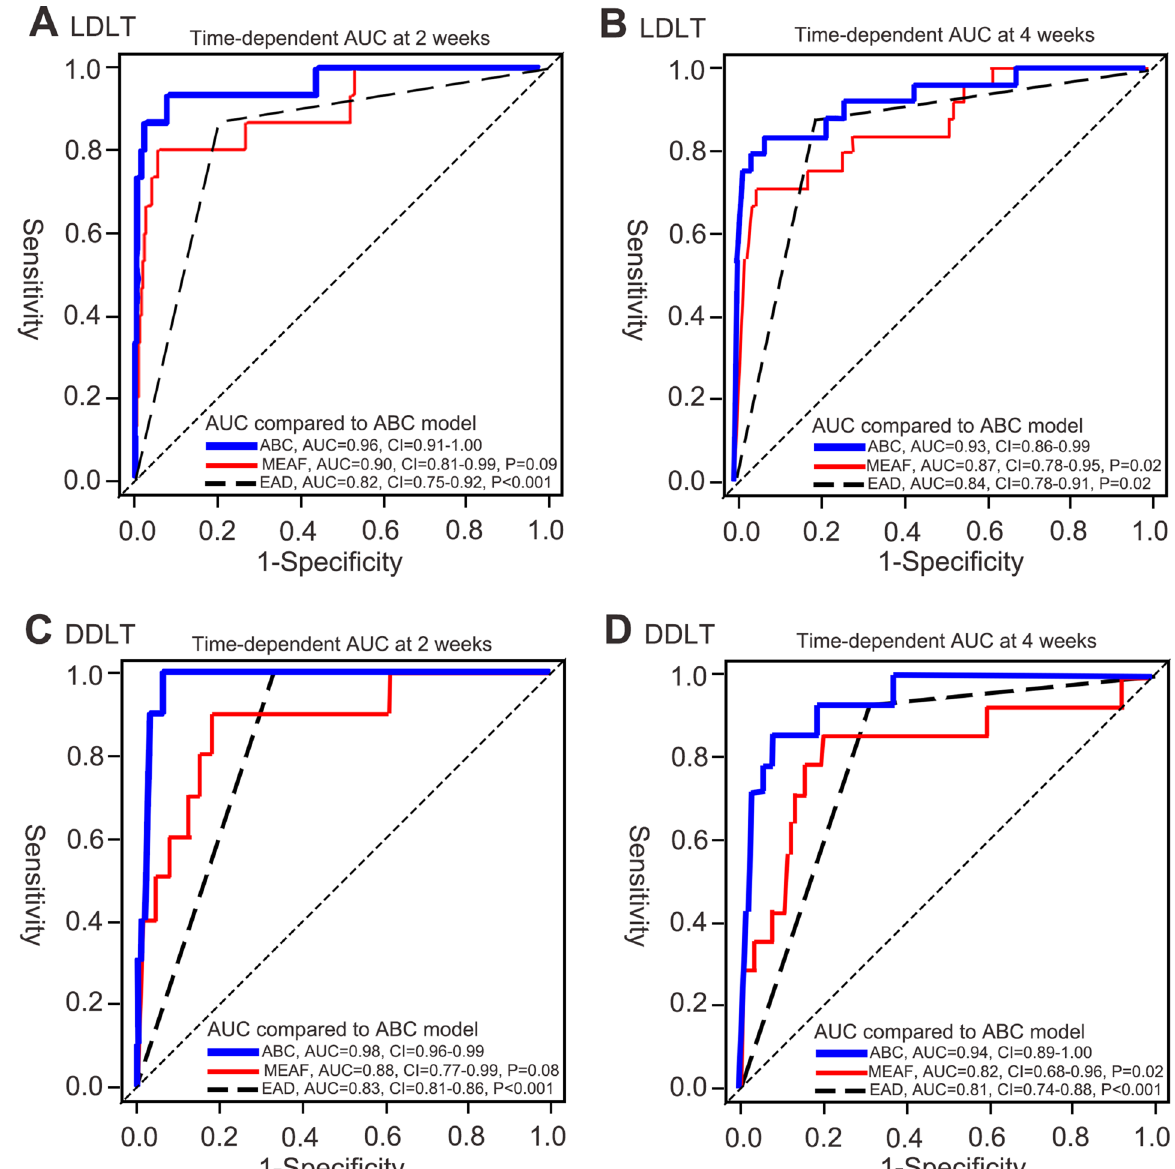
Figure 1. Comparison of time-dependent AUCs of ABC model, MEAF score and EAD criteria. ( A ) Time- dependent AUC at 2 weeks for LDLT. ( B ) Time-dependent AUC at 4 weeks for LDLT. ( C ) Time-dependent AUC at 2 weeks for DDLT. ( D ) Time-dependent AUC at 4 weeks for DDLT. The P values presented are comparison of AUC of MEAF score and EAD criteria against that of ABC